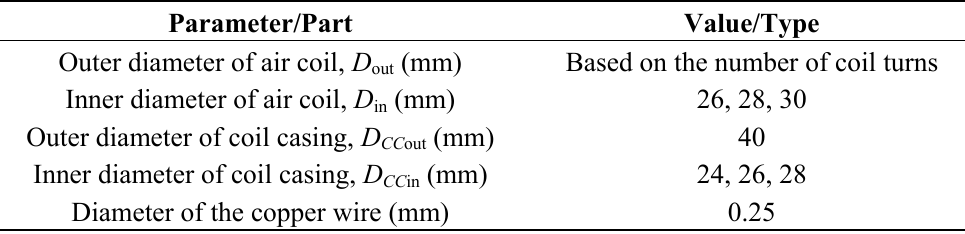
Table 3. Structure dimensions of the air